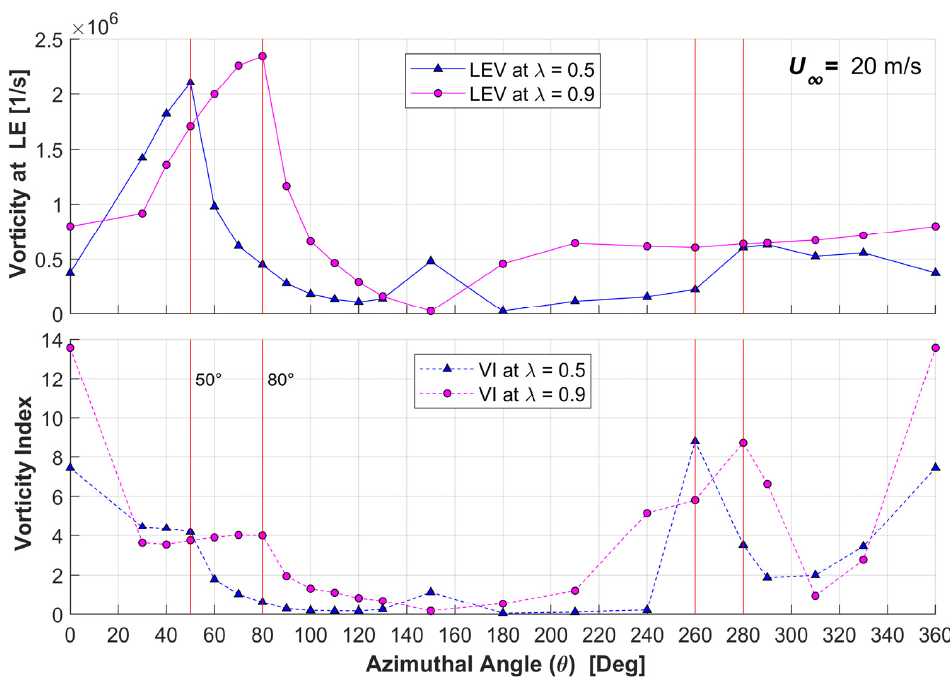
Figure 17. LE Vorticity and VI Values for Blade 1 at Various Azimuthal Angles for 𝑈 (cid:2998) = 8 m/s at 𝜆 =0.5 and 𝜆 =0.9.